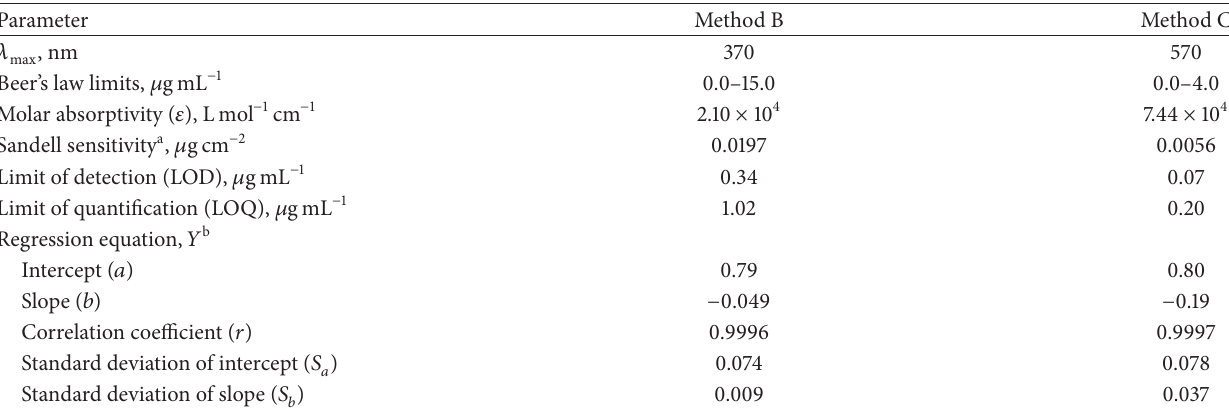
Table 2: Regression and analytical parameters.